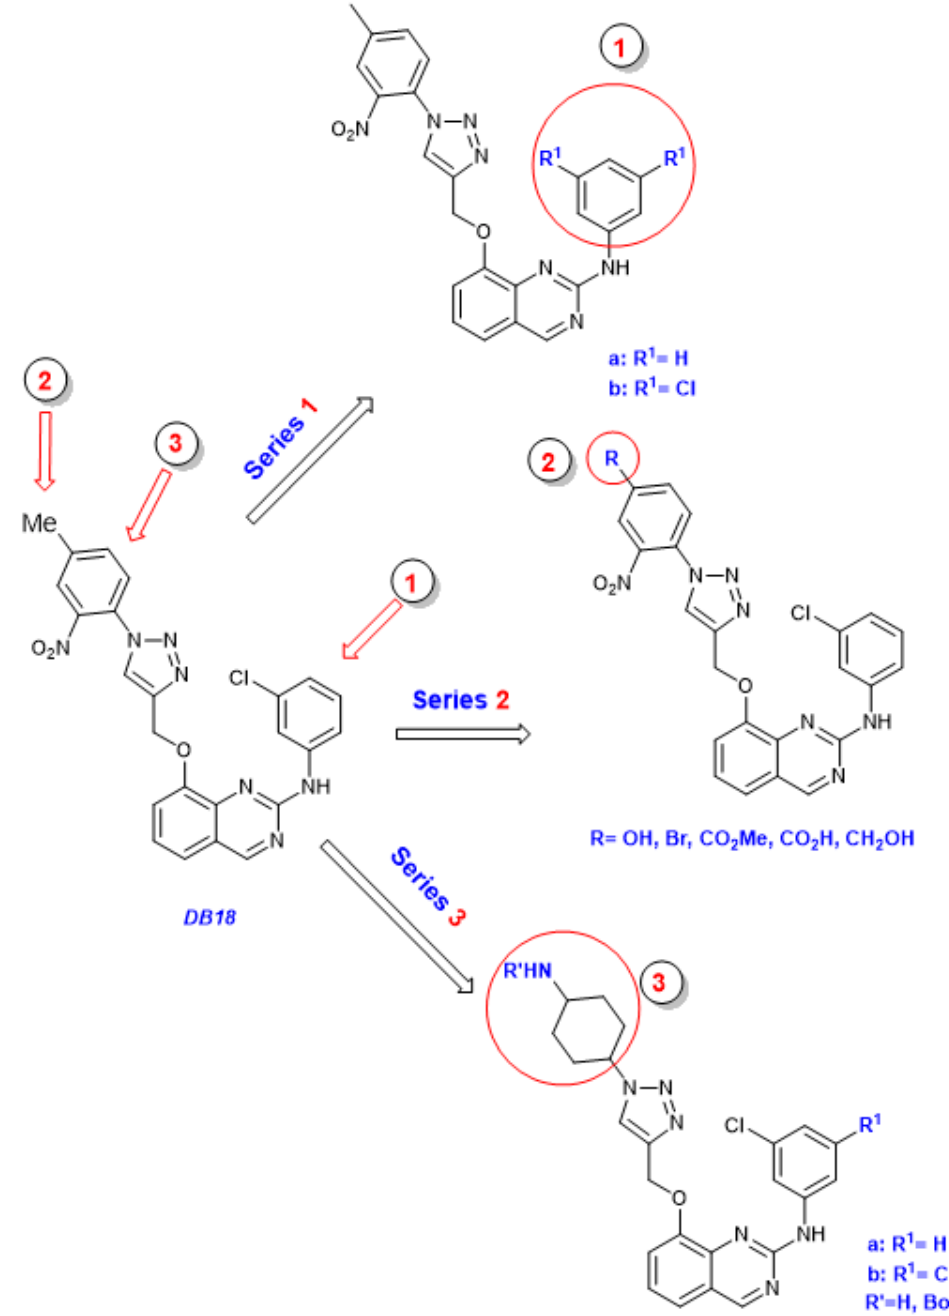
Figure 1. Design of the three series of target molecules .